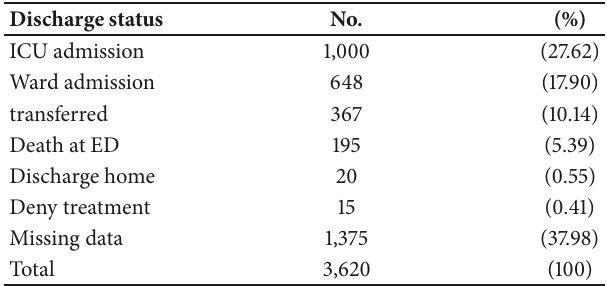
Table 7: ED discharge status of authorized patients. Discharge